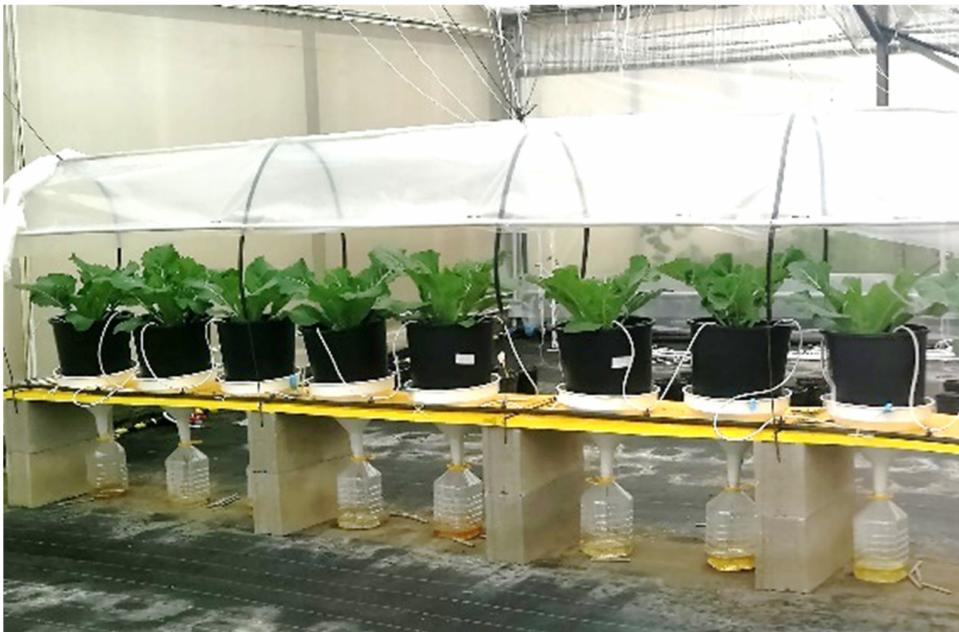
Figure 9. Preparation of the cauliflower plant growth experiment with water leaching collection bottles. Mineral nitrogen fertilizer application was carried out at (1) a conventional applica- tion rate (130 kg N · ha − 1 ), defined as normal dose (ND), and (2) a high application rate (260 kg N · ha − 1 ), defined as high dose (HD), in comparison with biochar-amended soils. The control was untreated (Figure 10). Mineral N fertilizer (calcium nitrate 14.4% N) was biochar (800–900 ◦ C, Syngasmart, Rieti, Italy to the soil, in a ratio of 3% compared to the